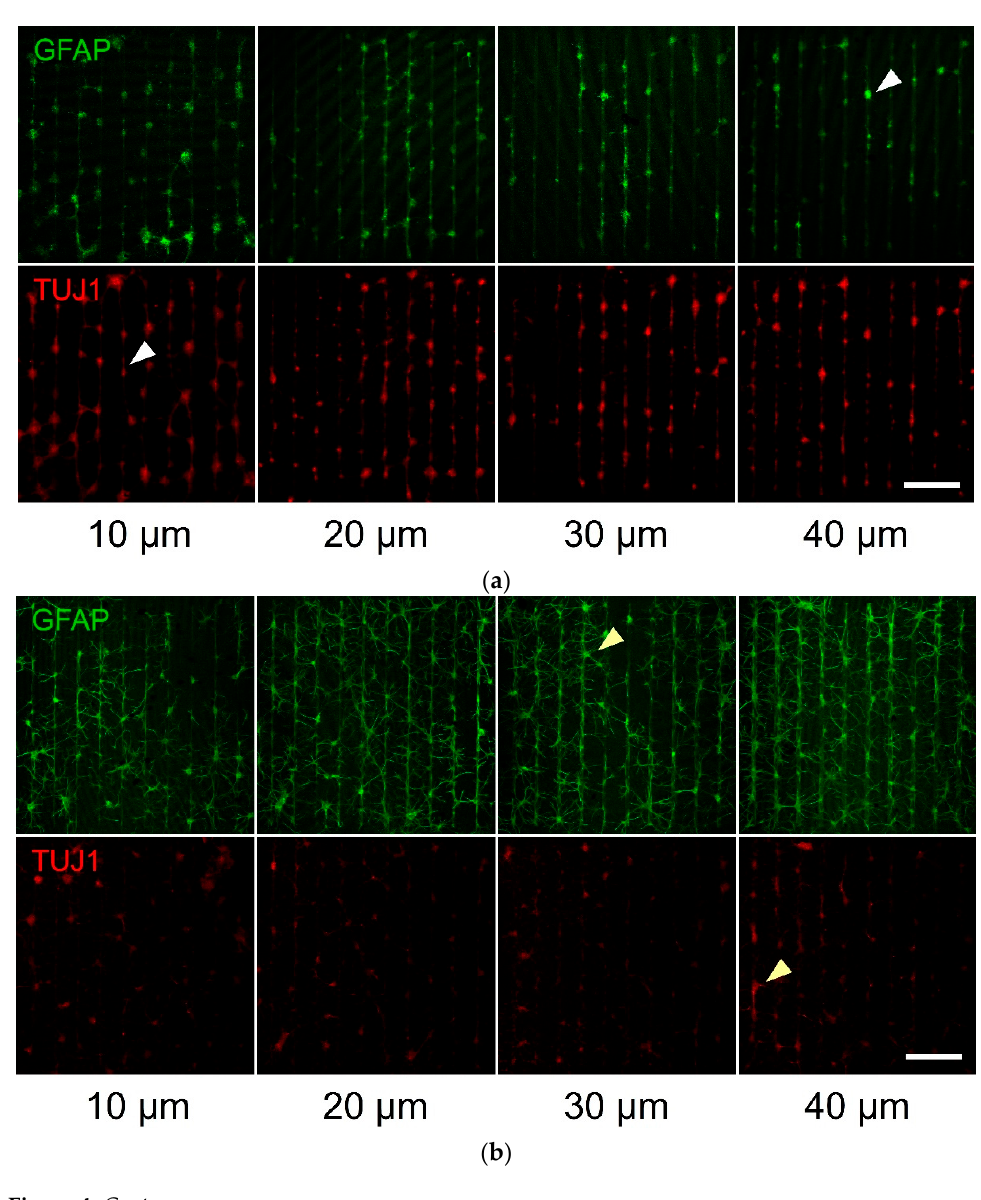
neurons (CI means—DIV7: 3.06, DIV14: 1.6, DIV21: 1.94, p < 0.001). As with prior results, geometry was not a significant factor in neuronal patterning (CI means—10 µ m patterns: 2.29, 20 µ m patterns: 2.22, 30 µ m patterns: 2.17, 40 µ m patterns: 2.13, p = 0.445, N = 9). With regard to astrocytes, there was a statistically significant difference between the 10 µ m pattern (CI mean: 2.18) and the 20 µ m (CI mean: 1.77), 30 µ m (CI mean: 1.68) and 40 µ m difference between the 10 μ m pattern (CI mean: 2.18) and the 20 μ m (CI mean: 1.77), 30 (CI mean: 1.58) patterns ( p < 0.01).